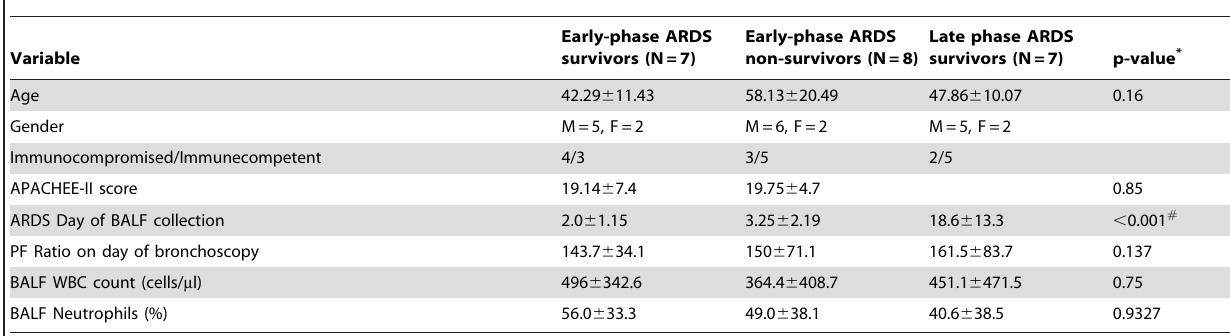
Table 1. Demographic and Clinical Characteristics of Subjects by Study Group.